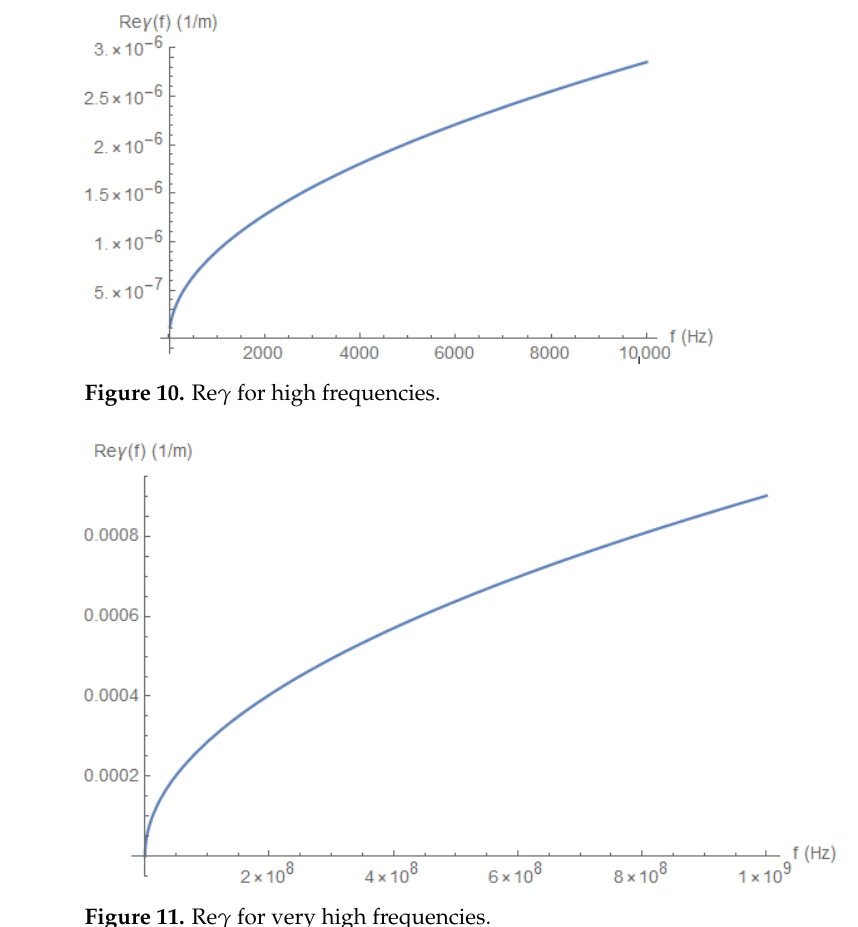
Figure 11. Re γ for very high frequencies.